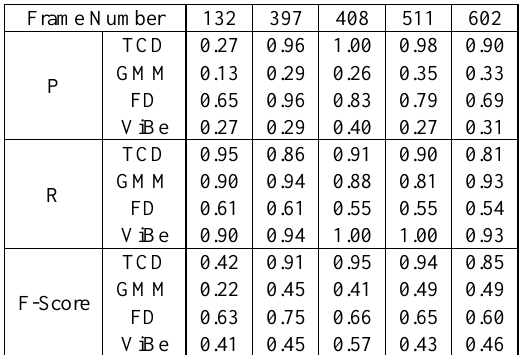
Table 1. Evaluation and comparison of each detection algorithm of the Skybox Sat-1